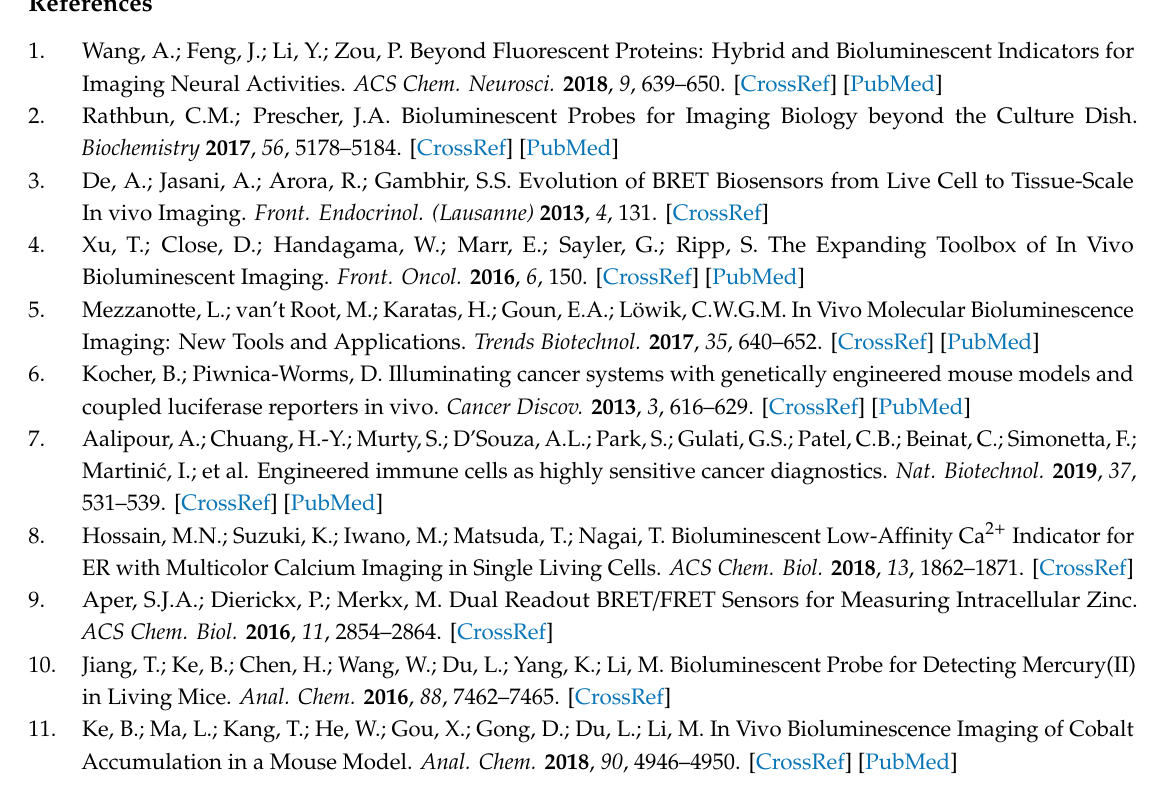
Figure S1: Protein sequences, Figure S2: FRET ATP dose-response curves, Figure S3: BRET ratio stability of a control construct, Figure S4: BRET ratio stability of ARSeNL, Supplementary